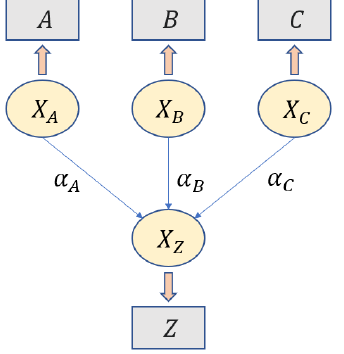
Figure 1. Example of a SEM representation describing a dependent feature Z as a function of three independent features, namely A , B and C . Rounded nodes represent the latent variables, whereas squared boxes denote their corresponding